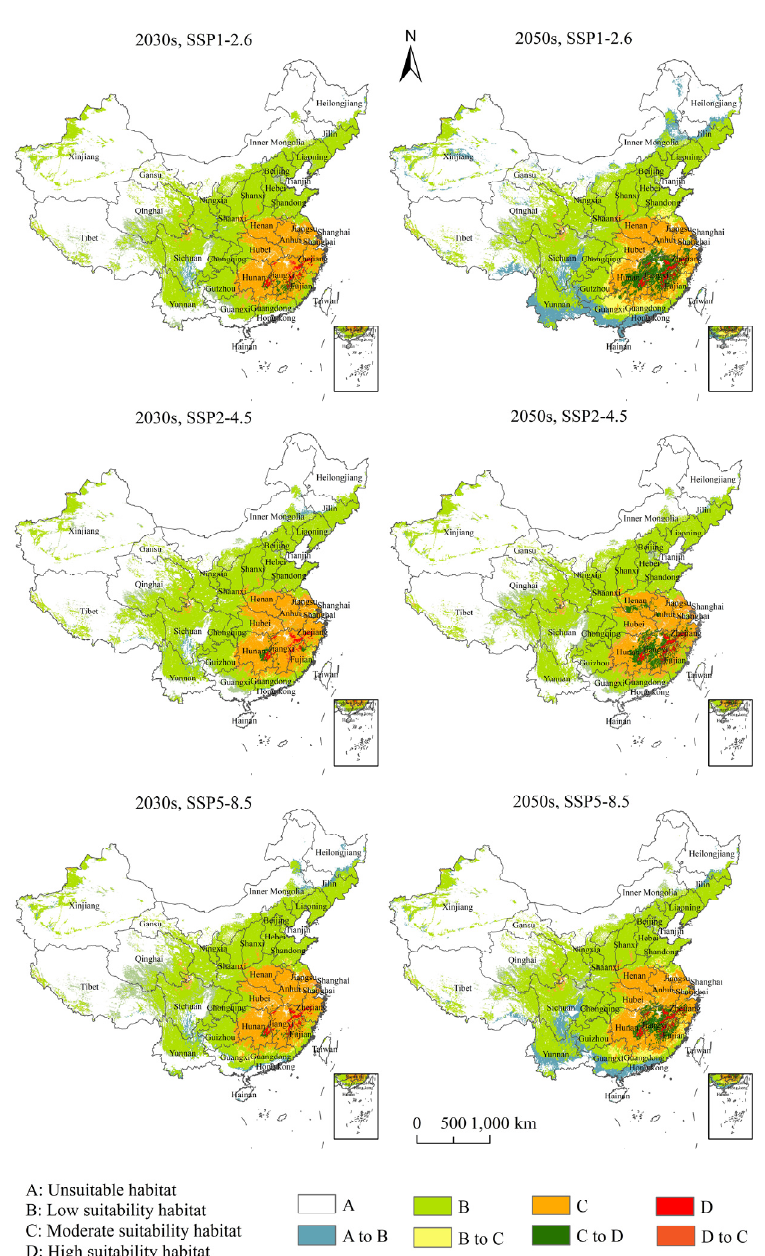
Figure 8. Changes in potential suitable habitats of Helicoverpa zea under different climate change scenarios from current to 2030s and from 2030s to 2050s in China. Note: SSP: shared socioeconomic pathways (see Table 2).